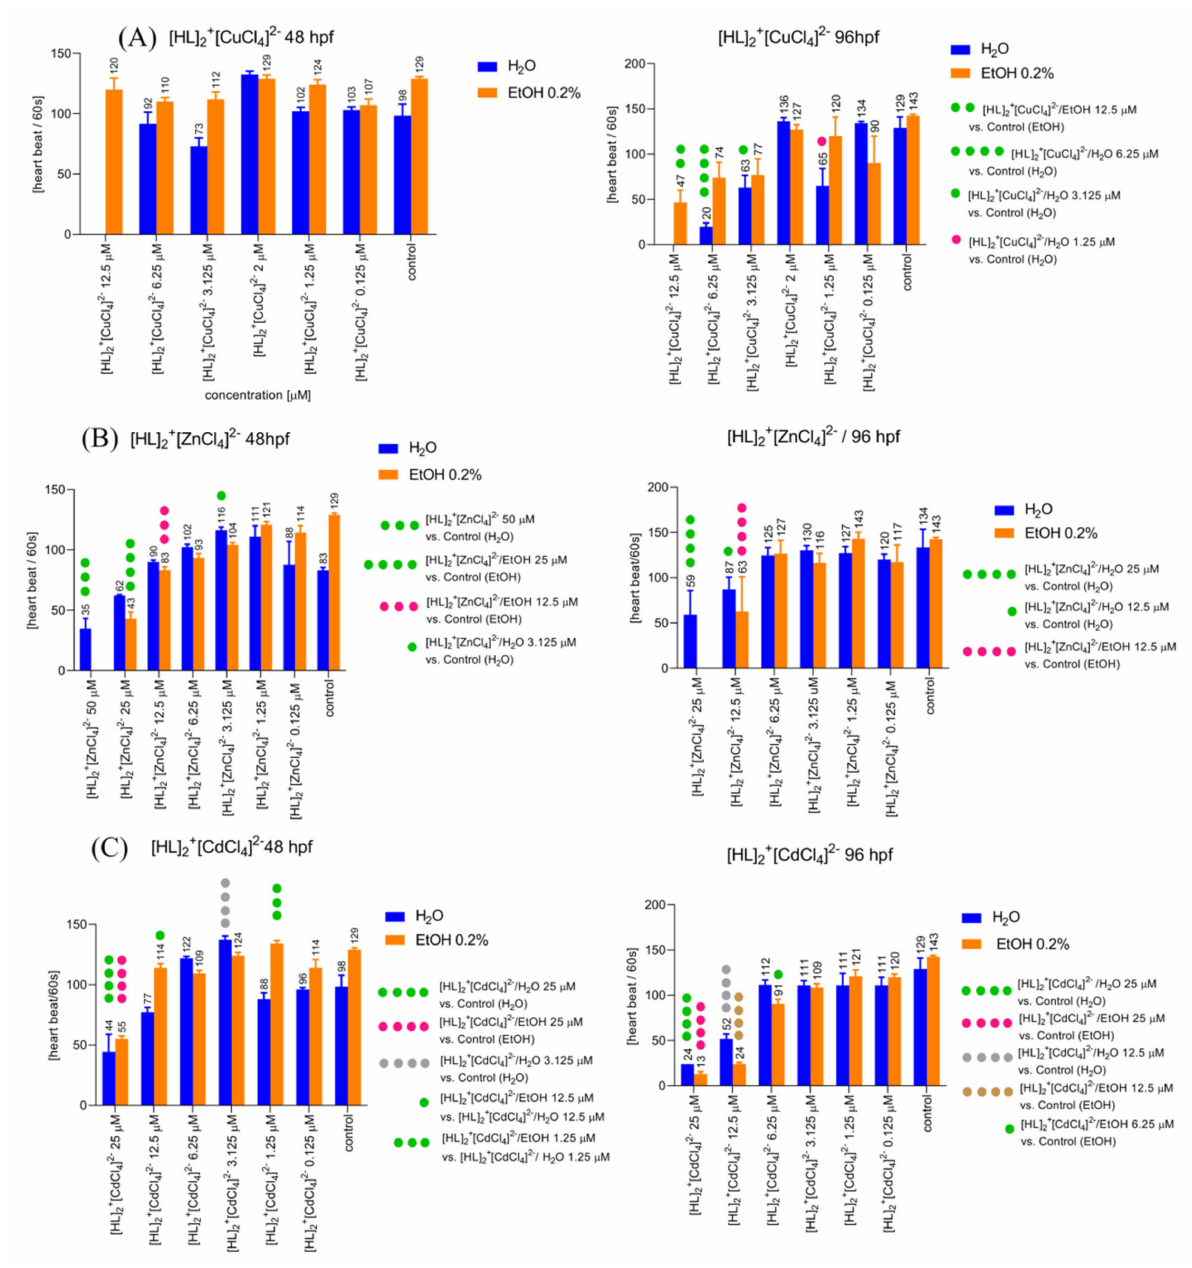
Figure 8. The [HL] 2 + [CuCl 4 ] 2 − ( A ), [HL] 2 + [ZnCl 4 ] 2 − ( B ), and [HL] 2 + [CdCl 4 ] 2 − ( C ) induced influences on the heart rate of Zebrafish larvae in 48 hpf (left) and 96 hpf (right) in the solvent-dependent manner of changes. Two-way ANOVA analysis showed statistically significant difference in heart rate after 48 h post fertilization (Figure 8B, left) as a response to used treatment (F (7, 85) =